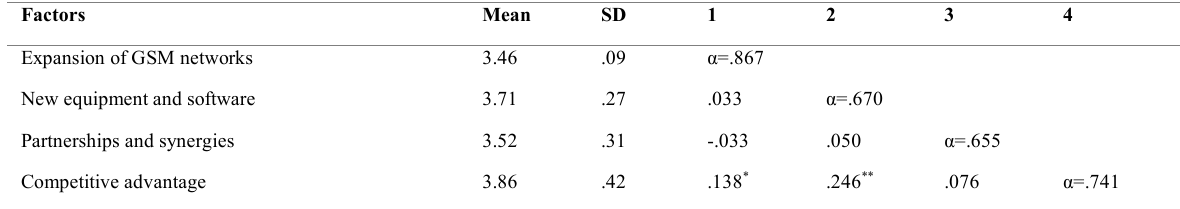
Table 1: Factor correlations, means, standard deviations and Cronbach’s